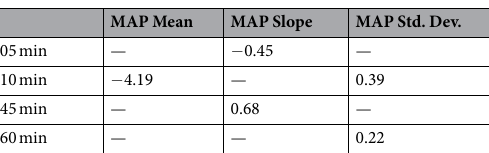
Table 4. Mean arterial pressure (MAP) feature coefficients in the logistic regression model. The β coefficients for significant features are listed; “-” indicates non-significant features. (None of the candidate features related to heart rate and vasopressor infusion dose were found to be statistically